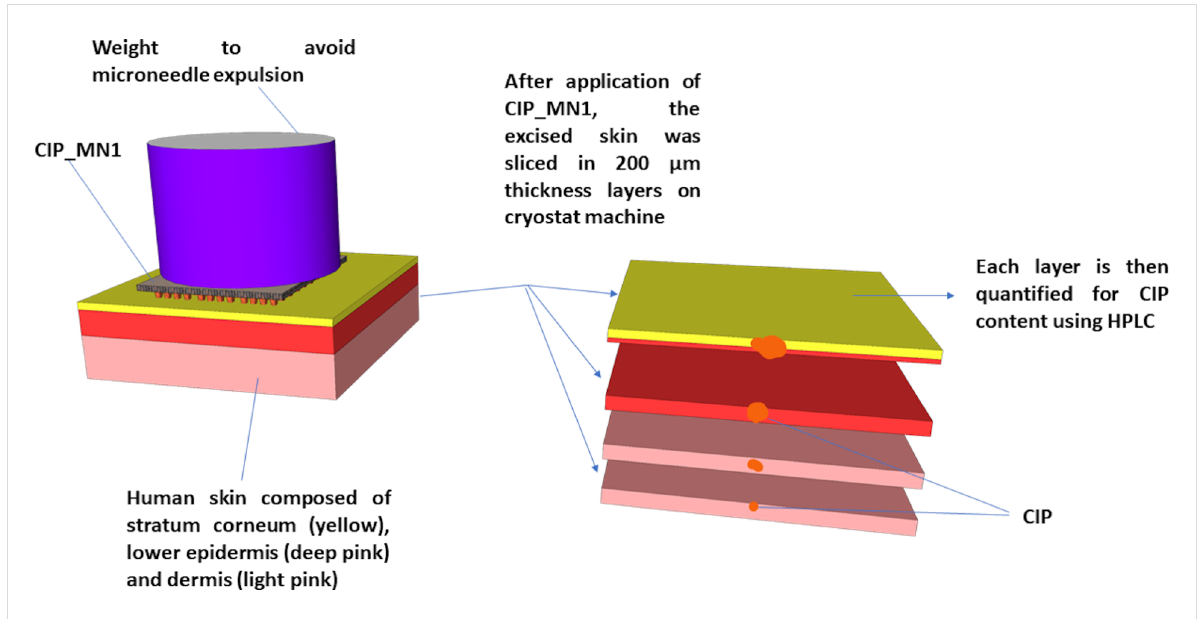
Figure 2: Schematic presentation of the skin deposition study of CIP_MN1. The full-thickness human skin was excised and treated. CIP_MN1 was then inserted into the skin using finger pressure applied to the microneedle baseplate for 30 s. A cylindrical 10 g stainless steel weight was placed on top of CIP_MN1 array to prevent expulsion of the microneedles, and the tissue paper was frequently wetted with PBS to prevent the skin from drying out. At each predefined time point, CIP_MN1 was removed, and the skin was sliced using a cryostatic